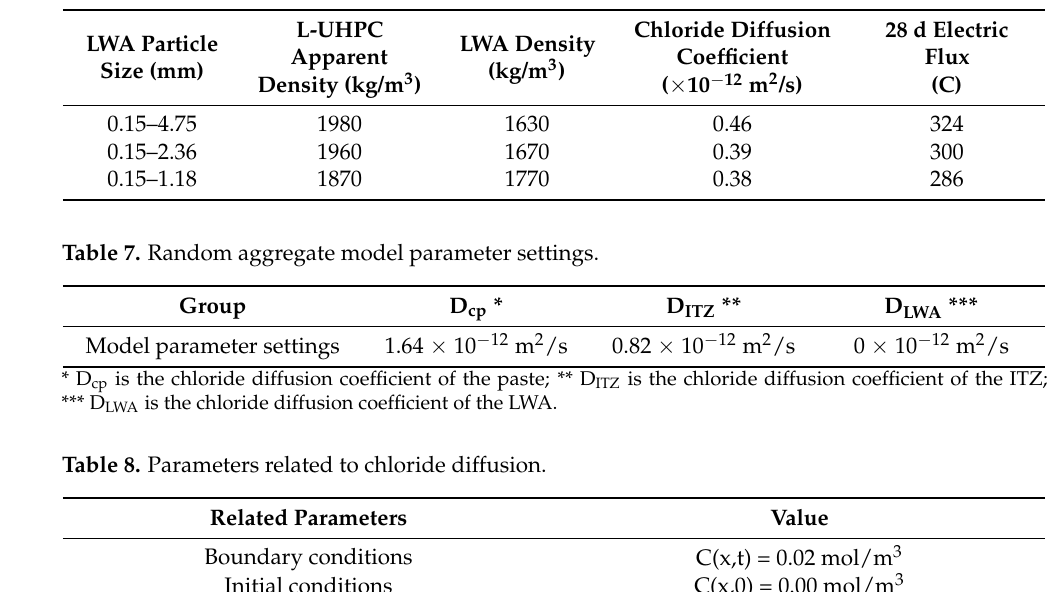
Model parameter set-